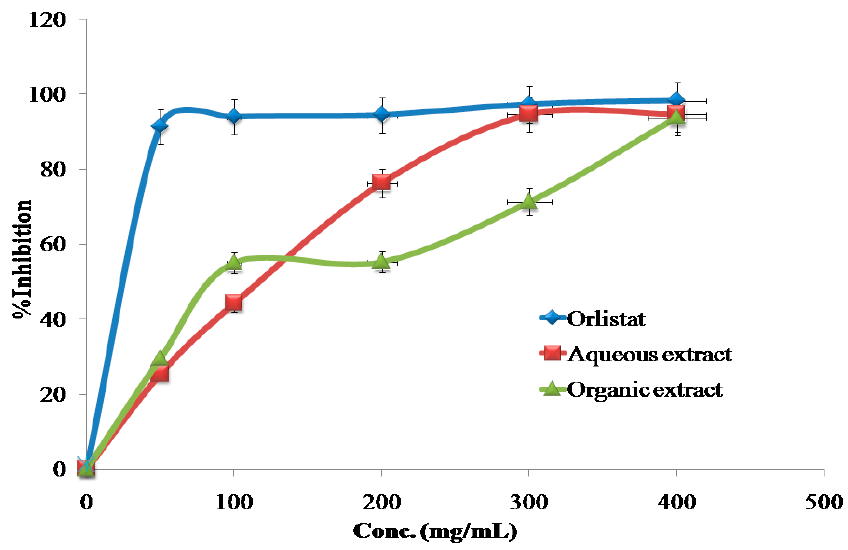
Figure 2. The inhibitory effects of the aqueous and organic extracts of B. nigra and Orlistat on the activity of porcine pancreatic lipase.